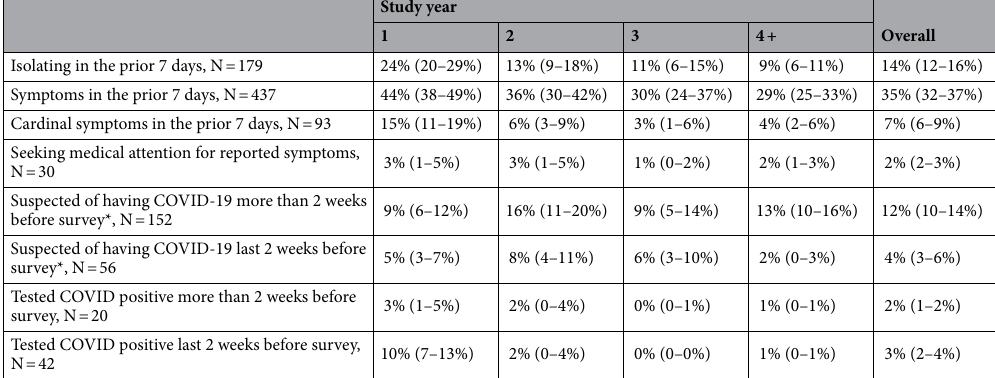
Table 2. Percentage (95% confidence intervals) of student participants isolating within the prior week, with symptoms within the prior week, or suspected of having/testing positive for COVID-19 (all weighted), overall and stratified by study year. *Medical professional’s opinion or personal suspicion.